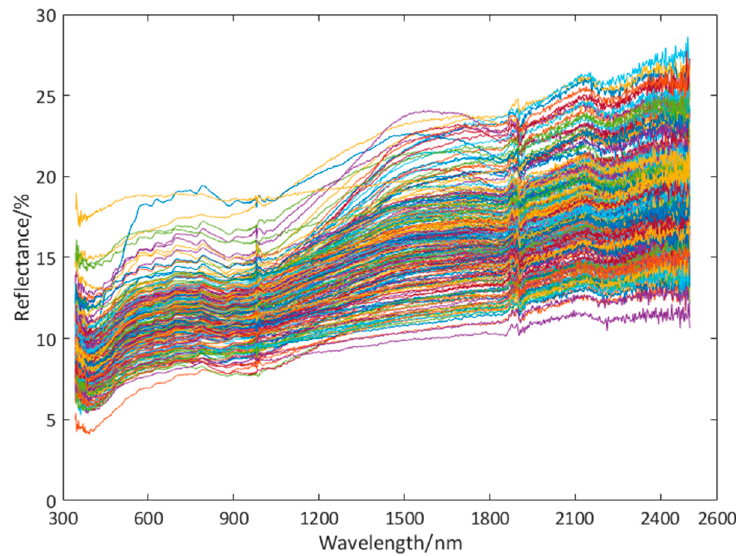
Figure 2. Spectrum of a copper ore.